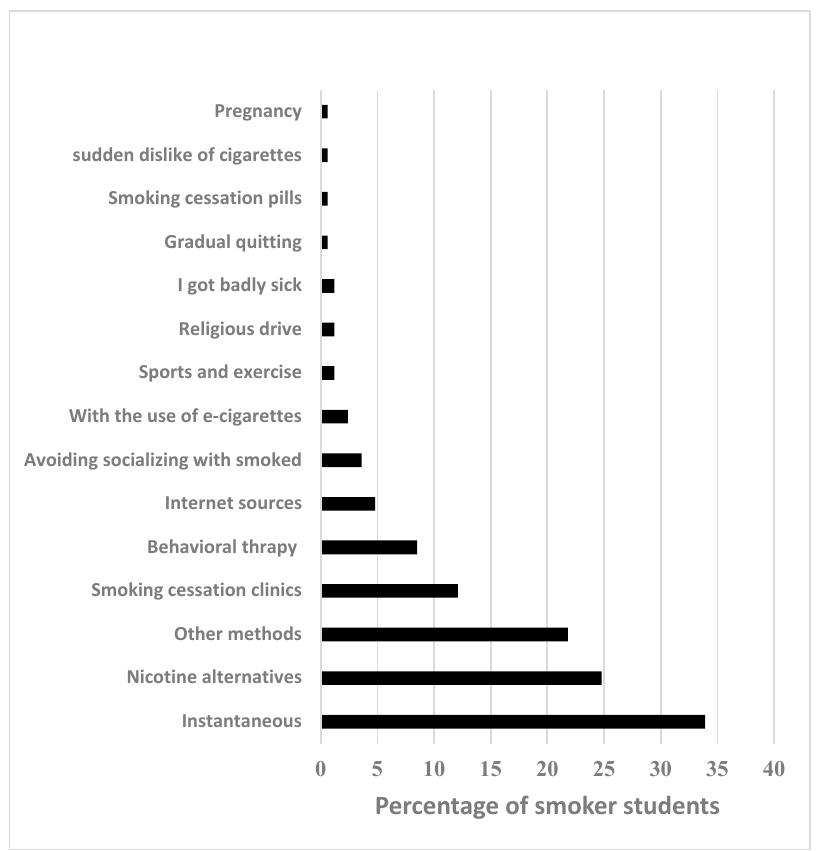
Figure 2. Methods/motivations for quitting cigarettes.